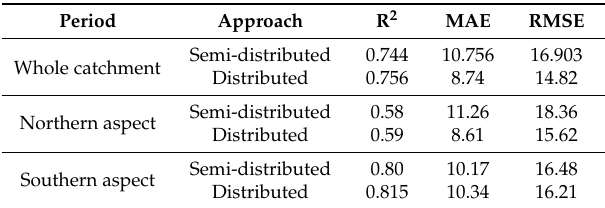
Table 4. RMSE, MAE and R 2 values for the observed and simulated SCA (based on the distributed and semi-distributed approaches) for 2006–2008 time periods for the whole catchment, Northern aspect (N, NE, NW) and Southern aspect (S, SE, SW).